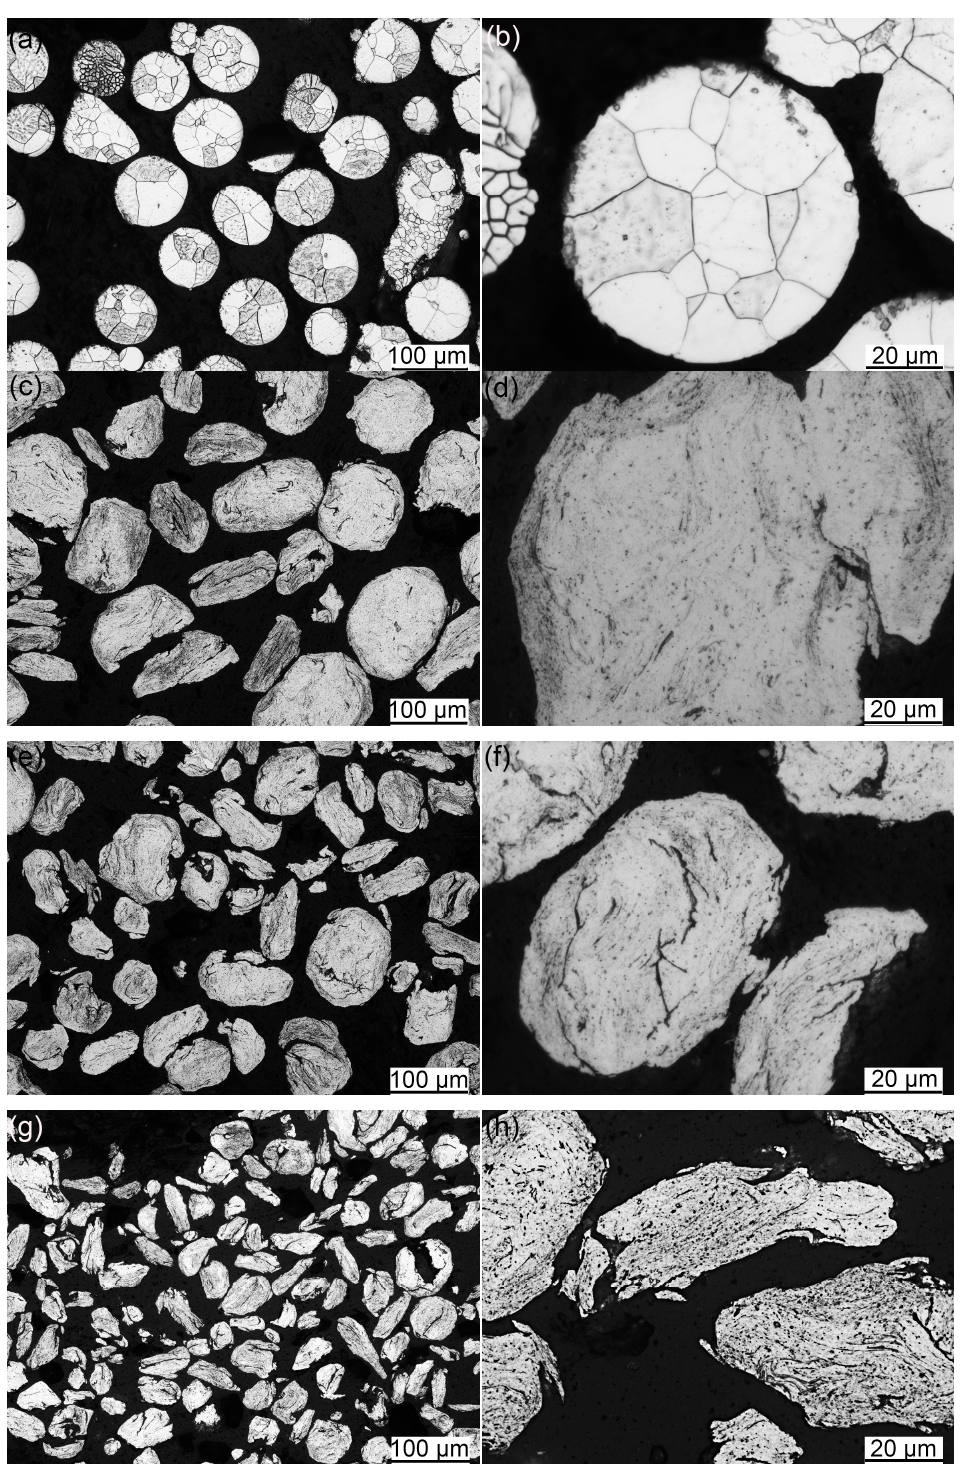
Figure 2. Optical microscope (OM) images of polished and etched powders at different magnifications: ( a , b ) pre-alloyed; ( c , d ) MP; ( e , f ) MX; ( g , h ) ODS.